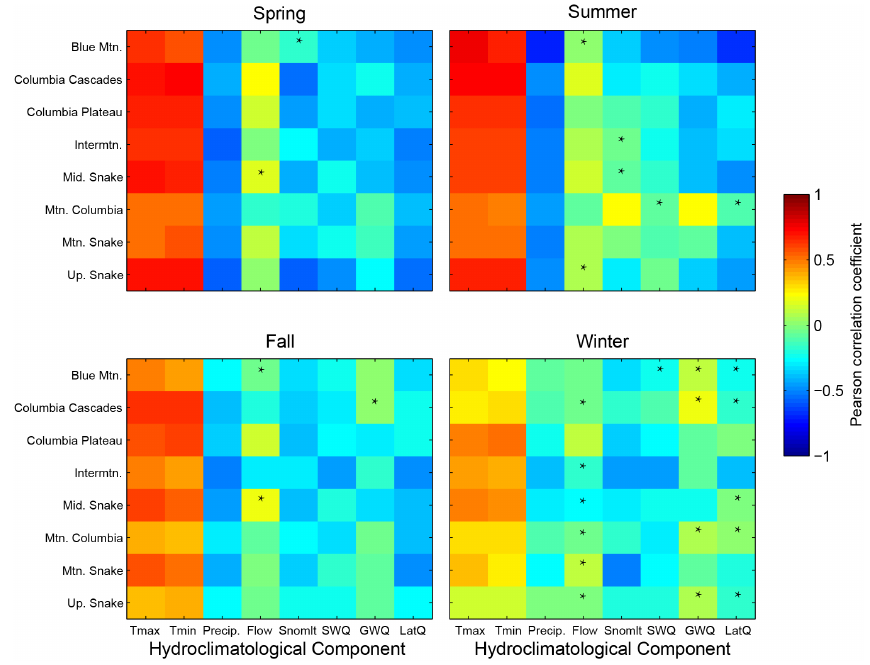
Figure 7. Pearson correlations between changes in stream temperature and hydroclimatological components for the Columbia River basin ecological provinces. T max = maximum air temperature; T min = minimum air temperature; Precip. = precipitation; Flow = streamflow; Snomlt = snowmelt; SW Q = surface water runoff; GW Q = groundwater inflow; Lat Q = lateral soil flow. Asterisks represent no significant correlation at p =